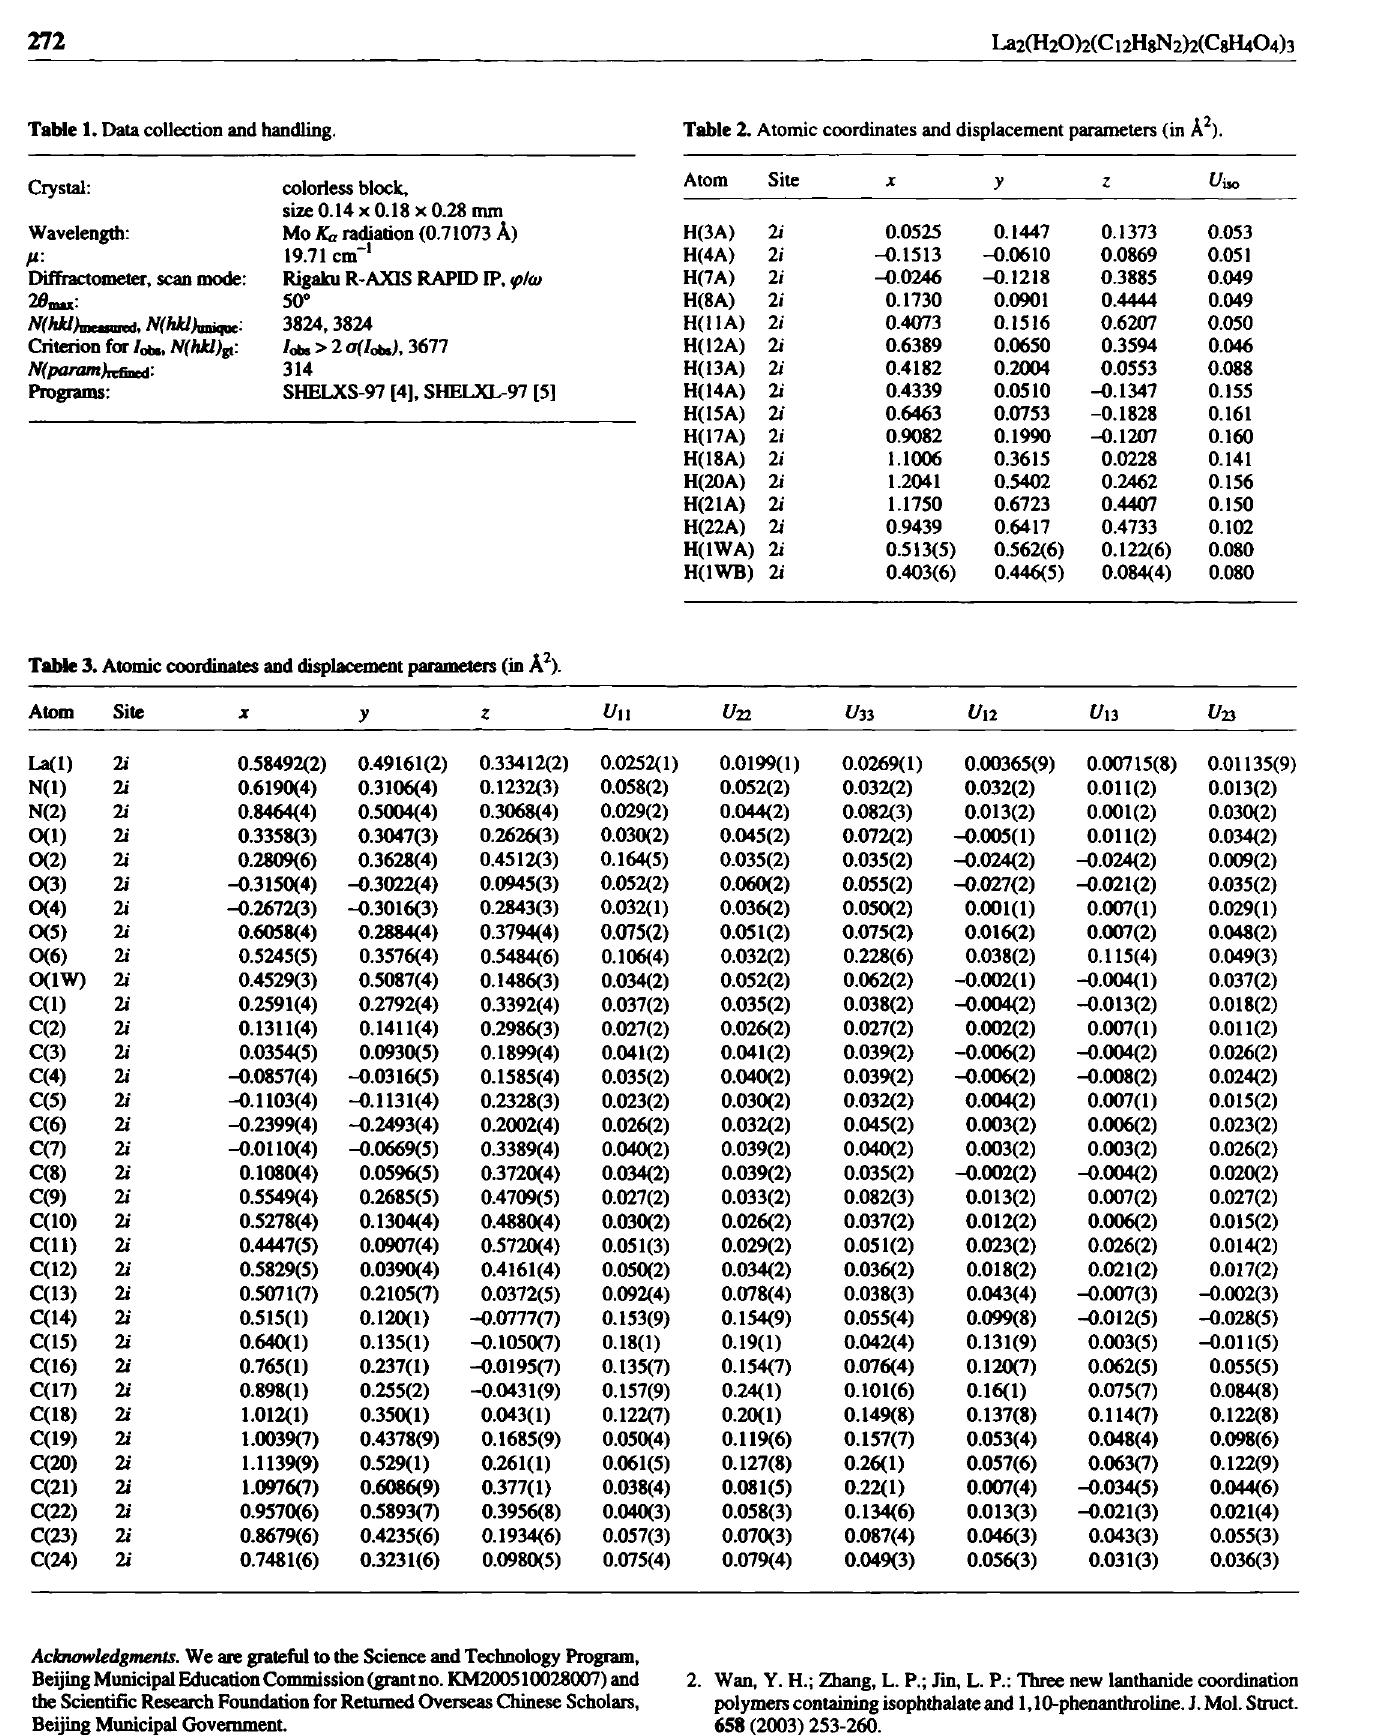
Table 1. Data collection and handling. Table 2. Atomic coordinates and displacement parameters (in A 2 ).